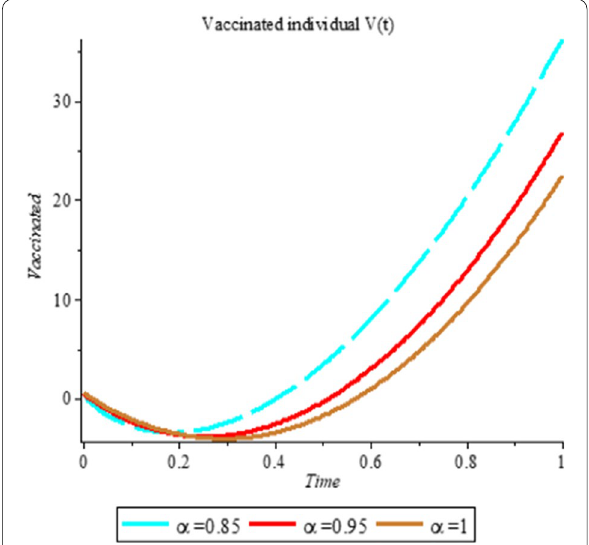
Fig. 2 Plot shows the behavior of V ( t ) at different values of fractional order α